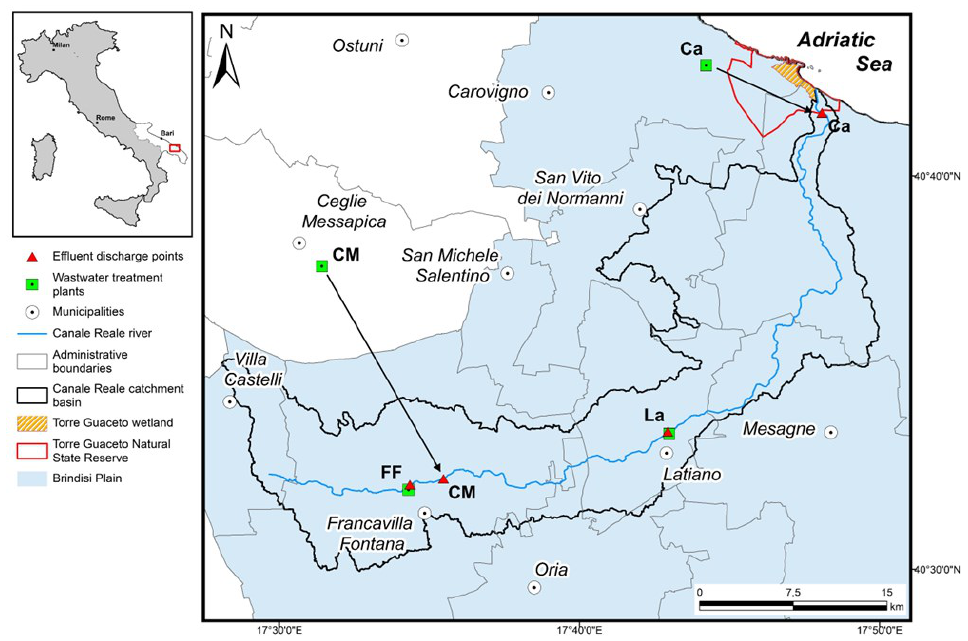
Figure 1. The geographical setting of the study area and distribution of the effluent discharge points along the Canale Reale River.